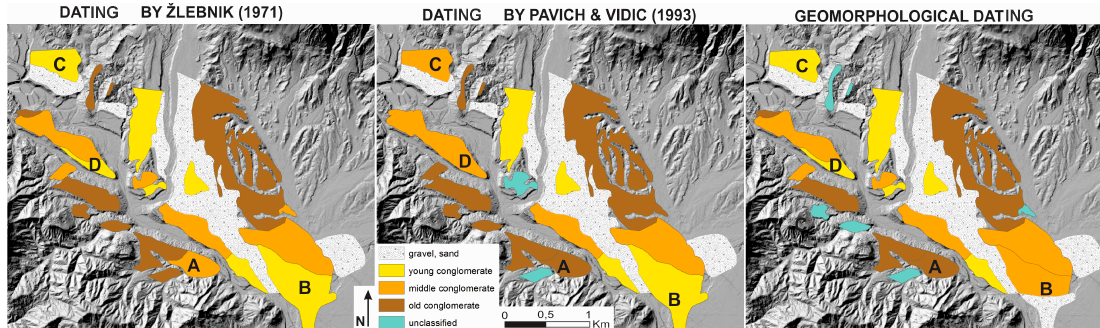
Figure 17. A comparison of geomorphological dating by the type of surface karstification with relative dating based on morphostratigrafic mapping and borehole data by Žlebnik [2] and absolute dating based on paleomagnetic and 10 Be analyses by Pavich and Vidic [22] in the wider area of the Ljubljana Basin. Discrepancies in geomorphological dating are marked with A–D.